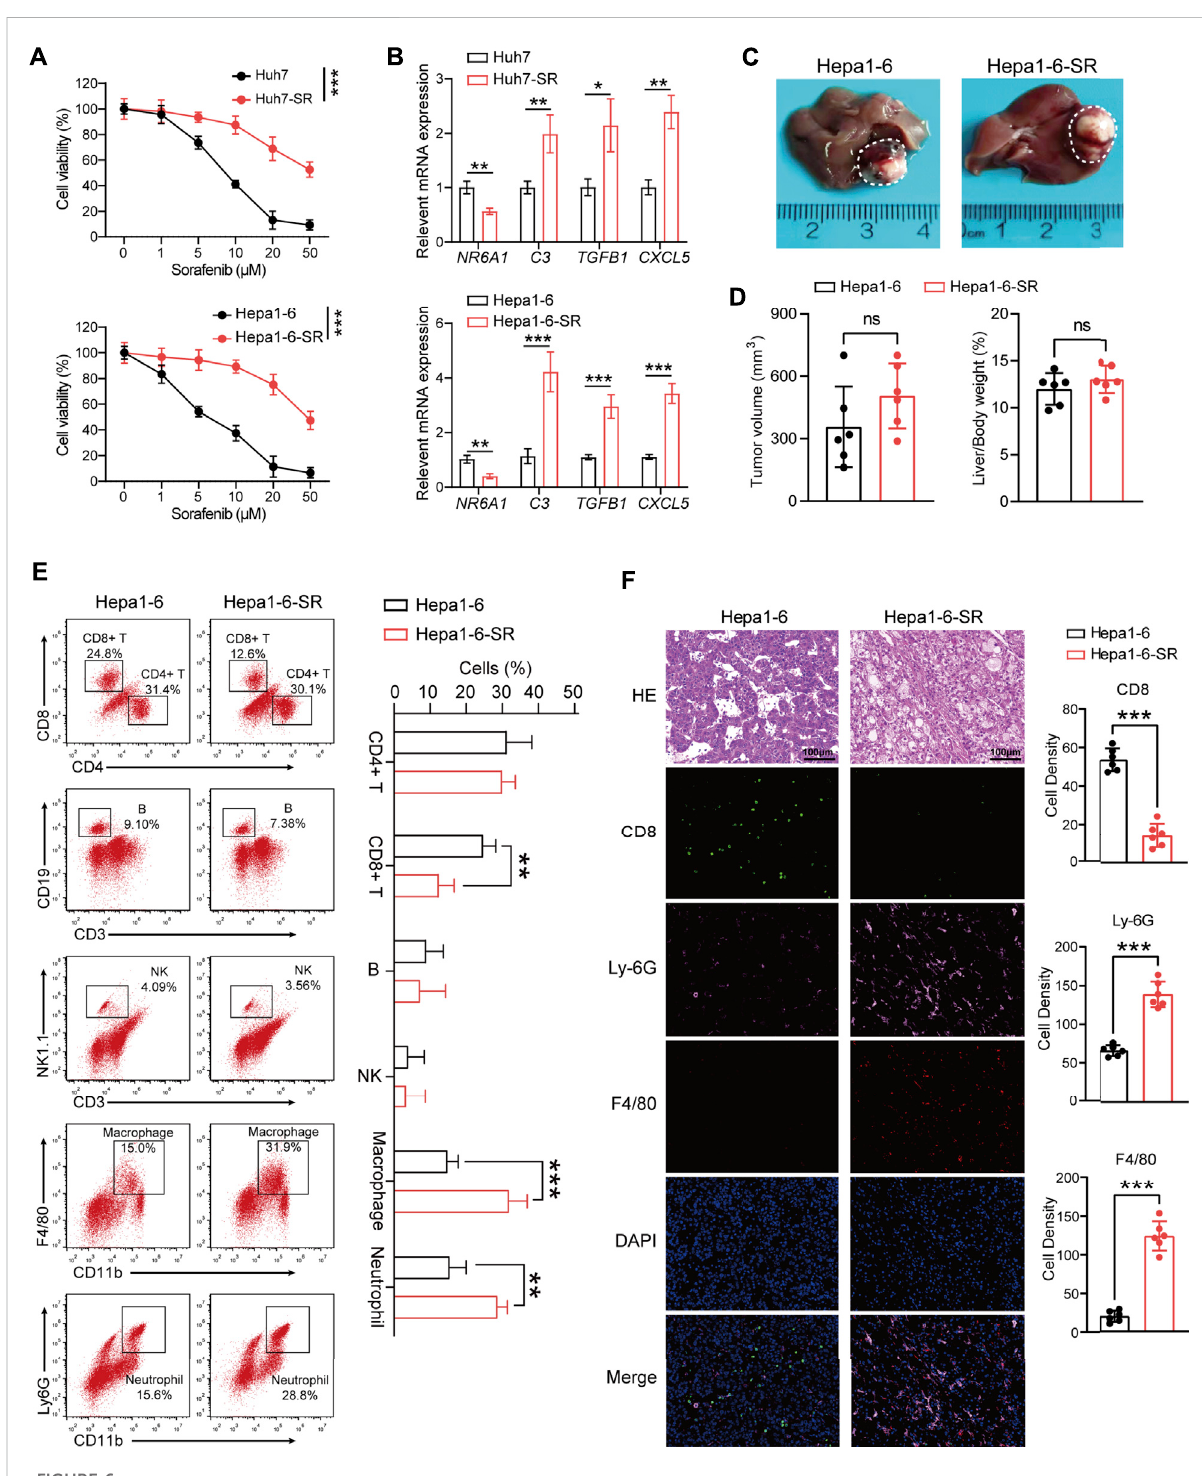
FIGURE 6 Tumor immune microenvironment analysis in the sorafenib-resistant HCC mouse model. (A) Two sorafenib-resistant HCC cell lines (Huh7-SR andHepa1-6-SR)wereestablishedandcon fi rmedbyCCK-8assay. (B) Expression values offourprognosticDEIRGs insorafenib-resistantHCCcells. (C) Representative images of the liver from a orthotopic xenograft sorafenib-resistant and control HCC mouse model. (D) Tumor volume comparison between the control and sorafenib-resistant HCC mouse model. (E) Representative immunocyte in fi ltration analysis using FCM in the mouse model. (F) Multiplex immuno fl uorescence staining CD8, Ly-6G, and F4/80 in control and sorafenib-resistant HCC